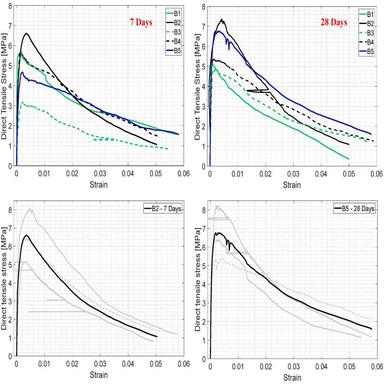
Direct tension stress–strain relationships of all NP-UHPC mixes tested at 7 and 28 days.